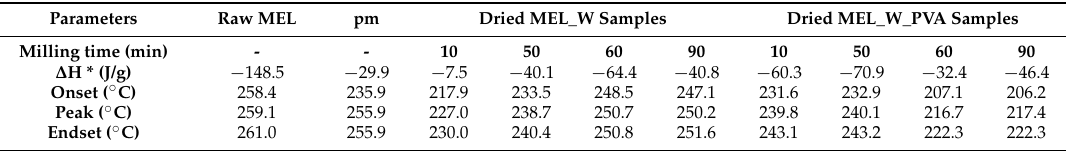
* ∆ H: normalized integral.